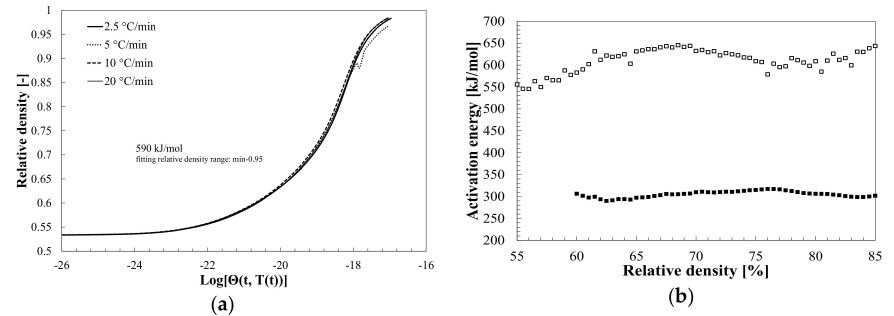
Figure 5. ( a ) Master sintering curve with corresponding apparent activation energy for natural sintering (i.e., in air, no pressure applied) of Mg-doped alumina. For all sintering curves, the data properly collapses into a single curve (except one artefact) indicating that a single predominant mechanism is active throughout the sintering cycle without any abnormal grain growth being expected to occur. ( b ) Apparent activation energies as a function of the density for natural (empty squares) and SPS (filled squares) sintering determined by the constant heating rate method. Extensive viscous flow in SPS sintering substantially reduces the apparent activation energy in the intermediate sintering stage [54]. (reprinted with permission of Materials Research